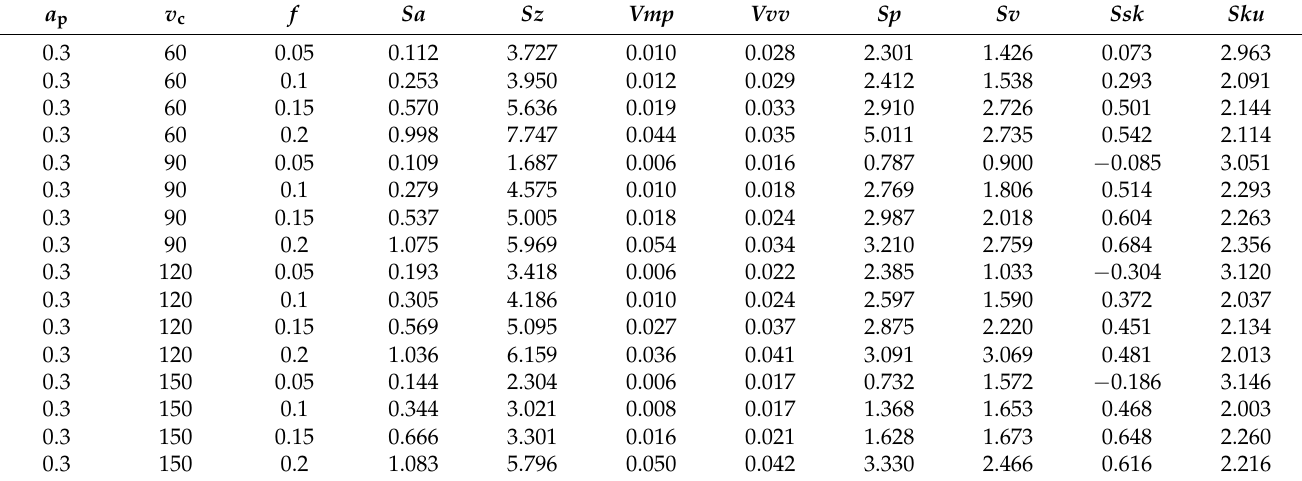
Table A4. Topography parameter data (hard turning, a p = 0.3 mm).